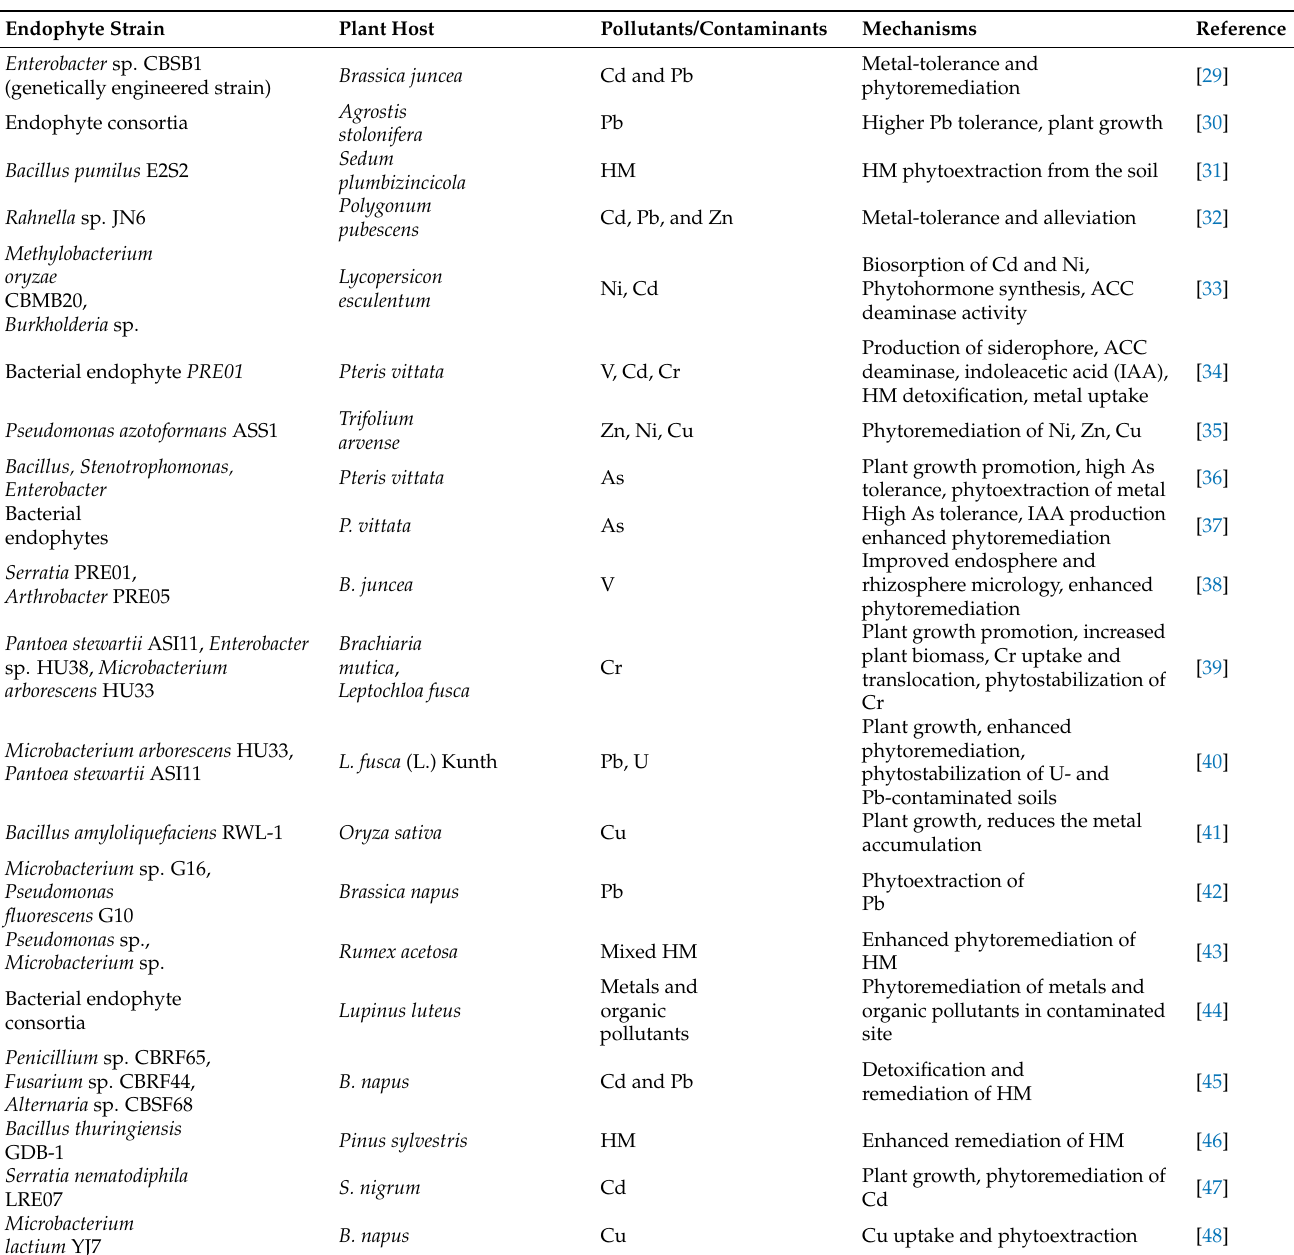
Table 1. Discussion of the bioremediation potential of plant-associated endophytes in the toler- ance/mitigation of HM-associated stress in plants, highlighting key